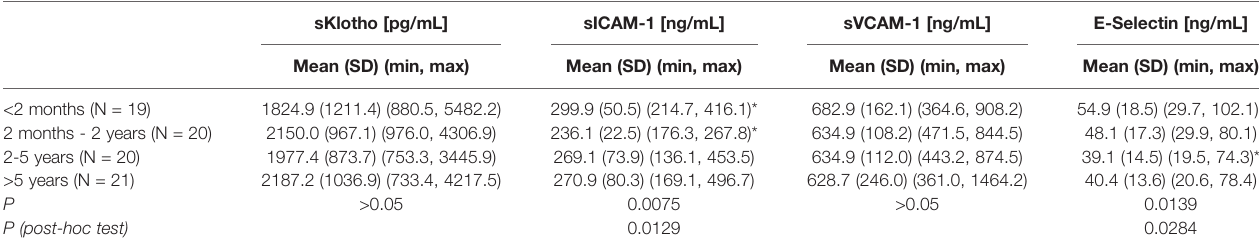
TABLE 2 | Concentrations of sKlotho protein and selected adhesion molecules in children with type 1 diabetes according to diabetes duration. sKlotho